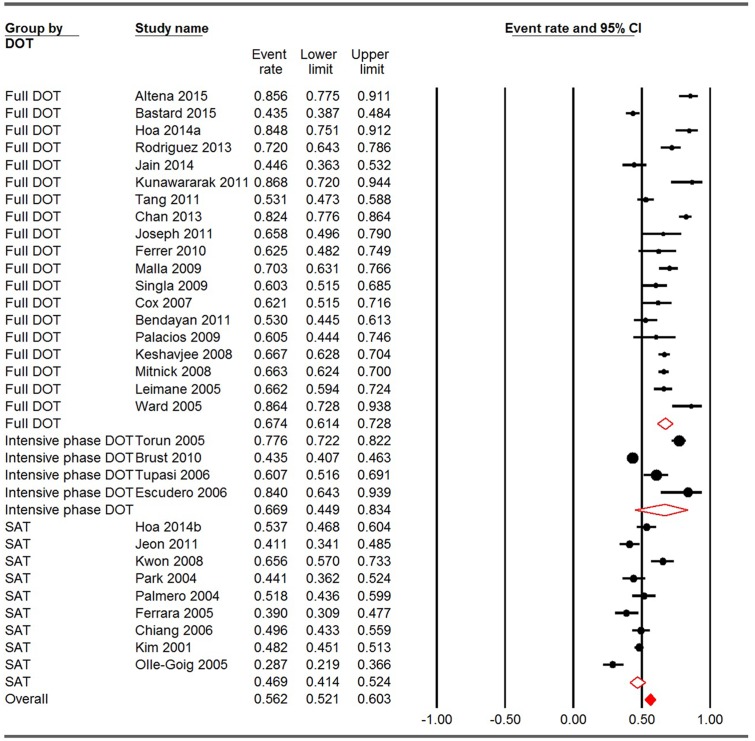
Meta-analysis of treatment success rates for studies using full DOT, intensive phase DOT and SAT.CI: confidence interval; DOT: directly observed therapy; SAT: self-administration therapy. I square for full DOT, incentive phase DOT and SAT were 91.323, 97.153 and 83.043, respectively. Q = 24.856, P<0.001. * The same study.